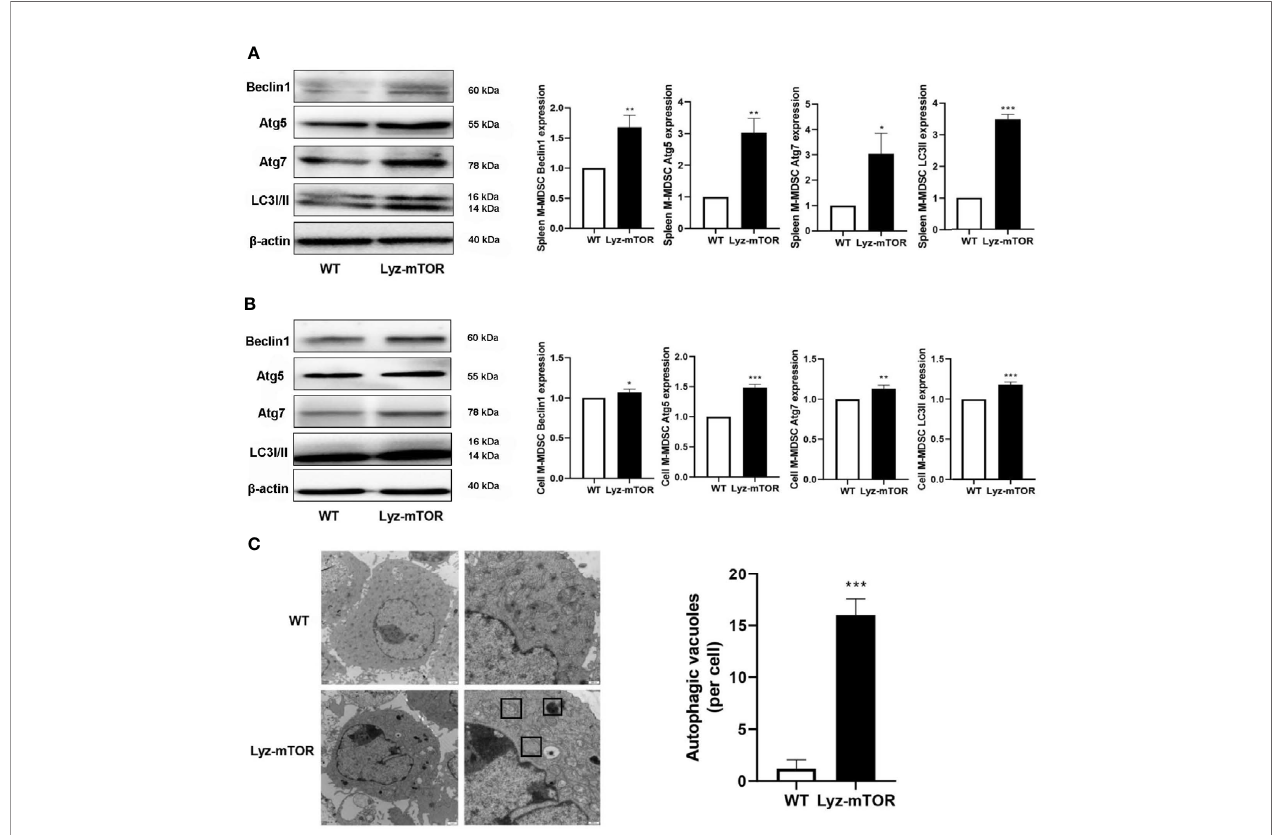
FIGURE 3 | Enhanced autophagy levels in M-MDSCs. (A, B) Spleen/induced M-MDSC intracellular autophagy-related proteins, such as Beclin1, Atg5, Atg7, and LC3I/II, were detected by western blot and normalized to b -actin. (C) Autophagic vacuoles were evaluated by electron microscopy (n = 5, *P < 0.05, **P < 0.01, and ***P <